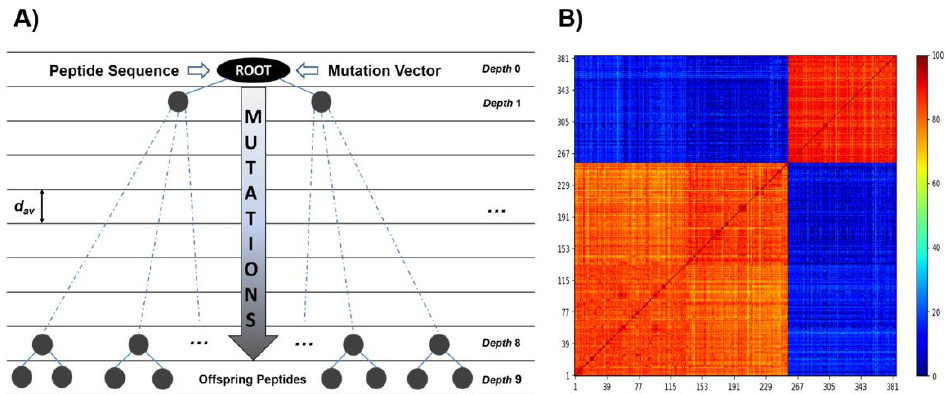
Figure 7. In silico design of a diversity-oriented peptide library. ( A ) Workflow illustrating the application of ROSE algorithm (https://bibiserv.cebitec.uni-bielefeld.de/rose, accessed on 12 March 2019). Root peptides and their corresponding mutation vectors are the input data. Besides the mutation vectors, ROSE also uses a binary tree to guide the stochastic point mutations on the root peptides. The binary tree topology is determined by the number of nodes (1023), depth (9) and average distance (dav = 5–20 PAMs). ROSE was calibrated to keep a minimum identity of ~70% of the generated peptides with the corresponding root sequence. The obtained library was composed of 385 unique peptides. ( B ) Heatmap showing the identity matrix among the generated peptides. Two blocks are distinguished, which corresponds to the root peptides selected from different fragments of IF1.